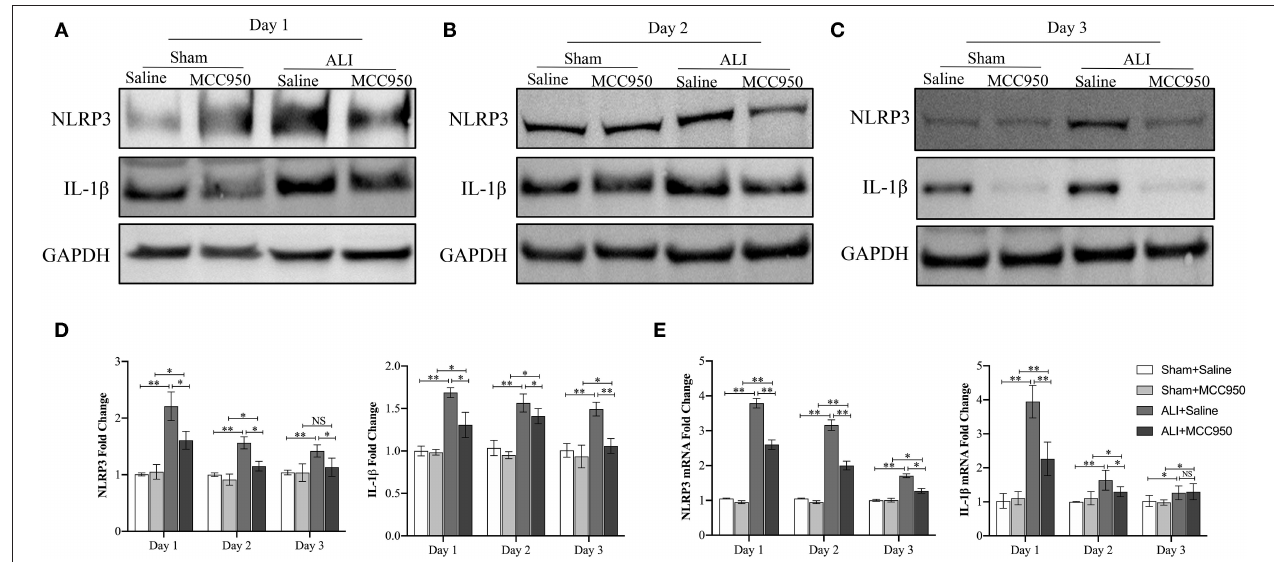
FIGURE 2 | The nod-like receptor family pyrin domain containing 3 (NLRP3) inflammasome activation in acute liver injury mice is inhibited by MCC950. Western blot analysis of NLRP3 and interleukin-1 β (IL-1 β ) protein level in liver tissues from CCl 4 -treated mice pretreated with vehicle or MCC950 on day 1 (A) , day 2 (B) , and day 3 (C) , GAPDH was detected as the loading control. (D) Quantitative analysis of western blots (A–C) , ( n = 3). (E) Real-time PCR (RT-PCR) analysis of liver NLRP3 and IL-1 β messenger RNA (mRNA) level in different mice. Data are presented as mean ± SEM. NS: No significance. * p < 0.05, ** p < 0.01. Intergroup differences are determined by the Student’s t